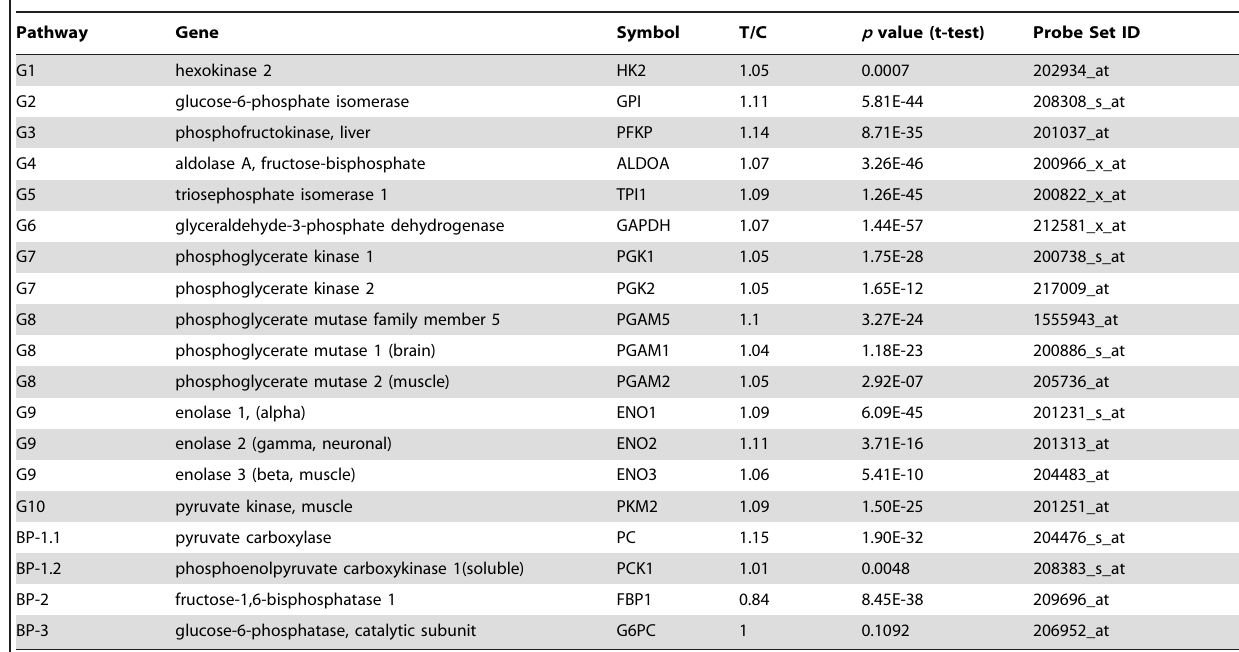
G1-G10: Glycolysis step 1 to step 10. BP1-3=gluconeogenesis bypass step 1 to step 3. T/C=expression level ratio between cancer and control.